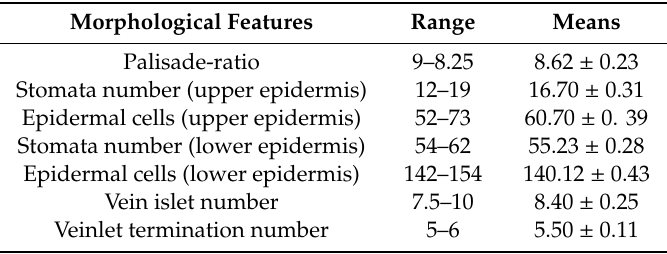
Table 1. Quantitative leaf